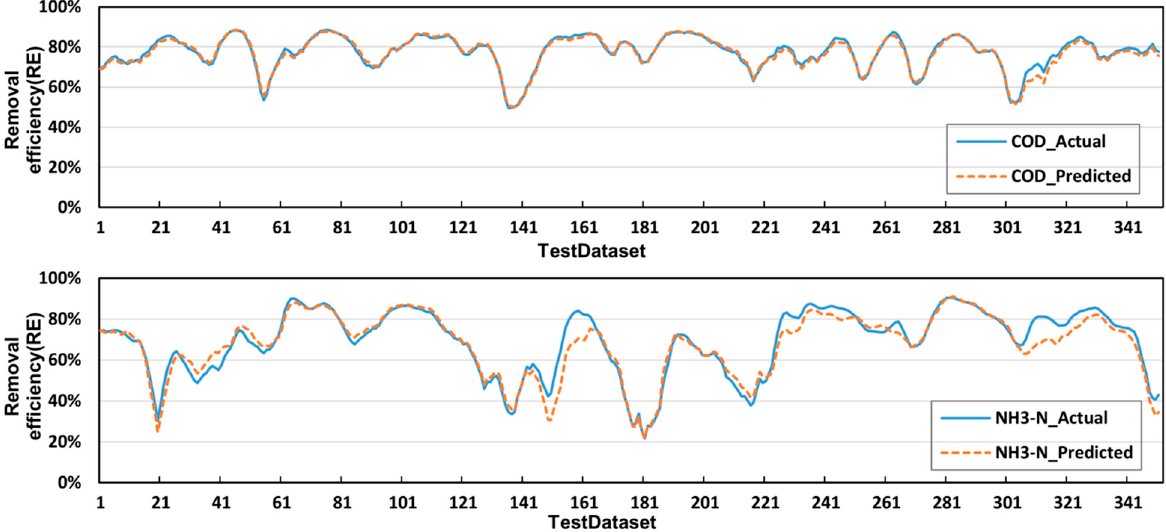
Figure 7. Comparison of the predicted and actual RE for the untrained testing set with 351 samples at a prediction interval Δ t : 9 h.